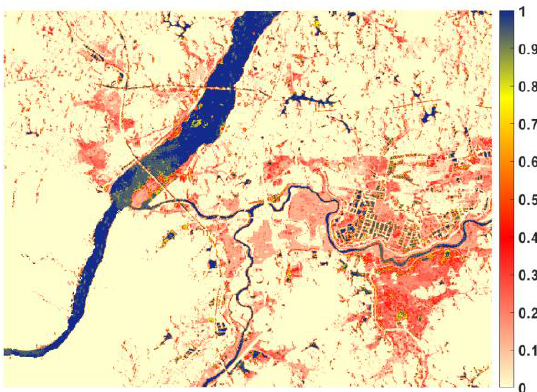
Figure 7 Frequency map of water bodies of Qingyuan. The image represents how often each pixel point was identified as a water body during this period. The closer a pixel value is to 1, the more the pixel can be identified as the permanent water body. The results of water body extractions were considered as seasonal water bodies, except for permanent water bodies. time in the long time series. In the frequency map of water areas are close to 1, while the frequency of water bodies in